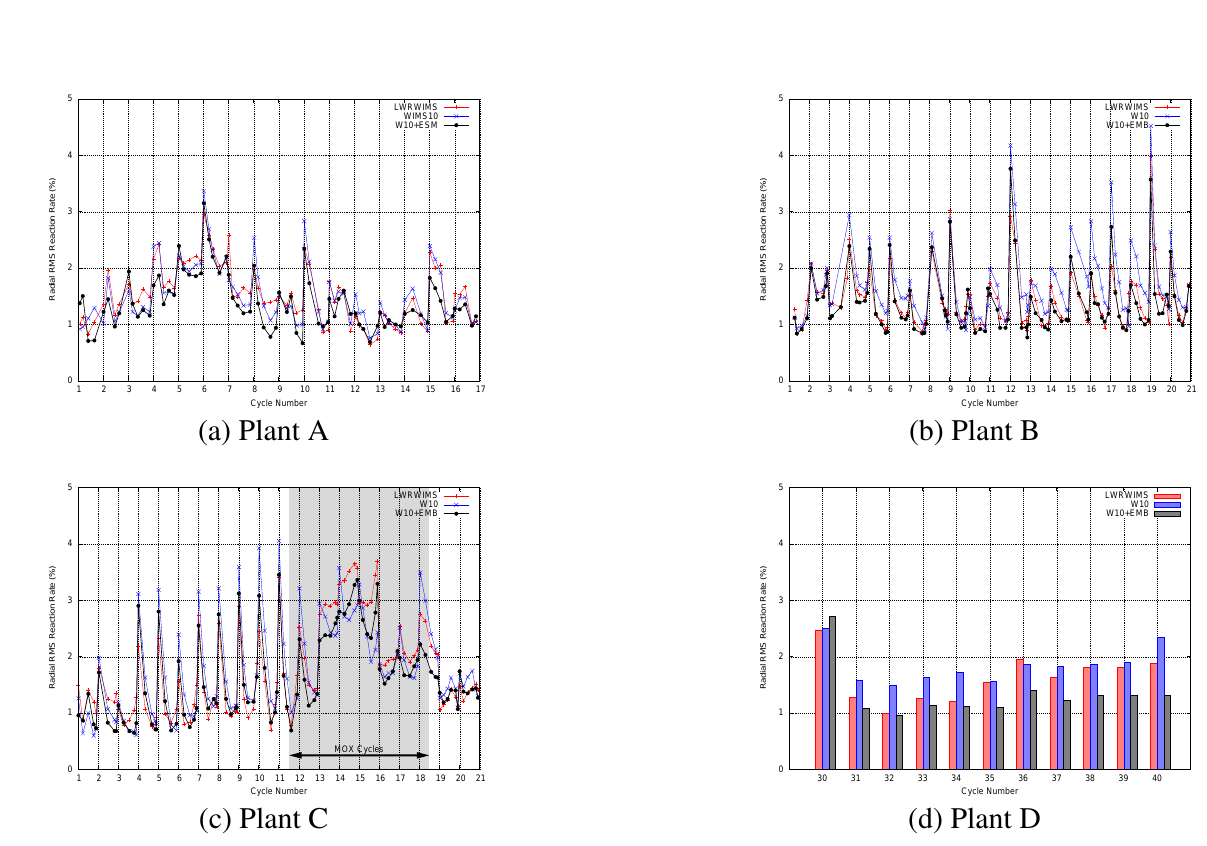
Figure 5: RMS Radial Powershape error as a function of time; Full Power Maps